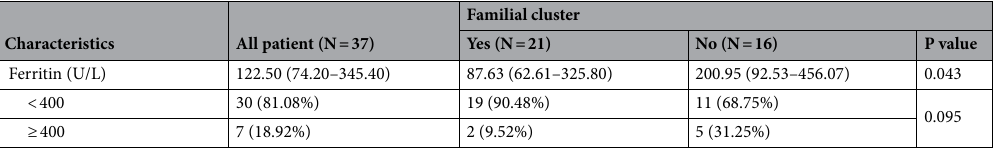
Table 2. The laboratory findings for all the patients and the subgroup divided by family cluster.